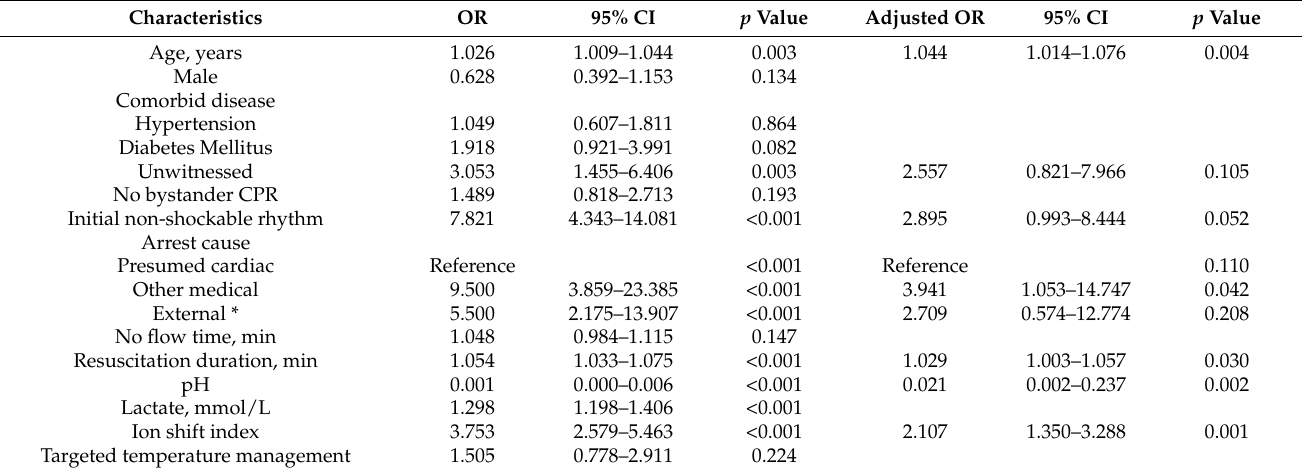
Table 2. Logistic regression analysis for a 6-month poor neurological outcome in the patients with out-of-hospital cardiac arrest.